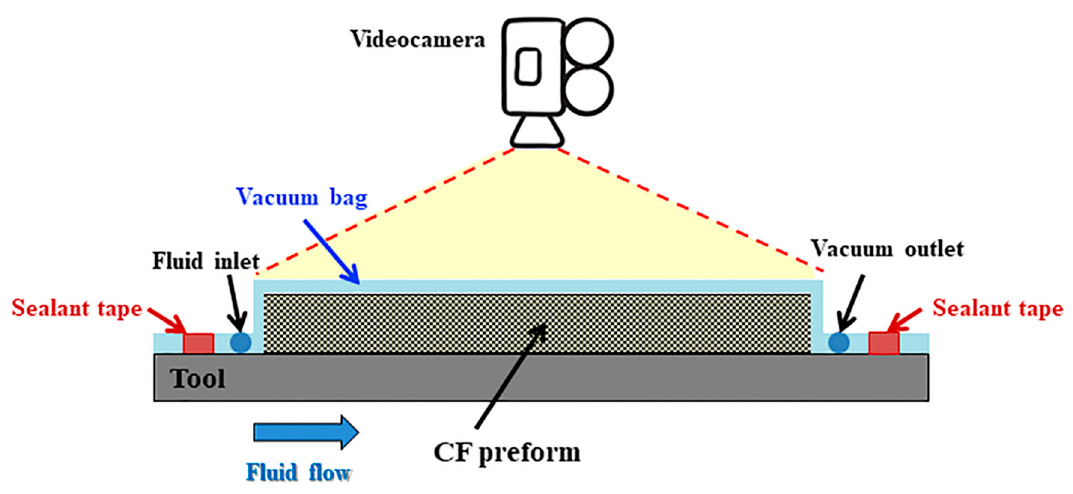
Figure 2. Sketch not in scale for the measurement of the in-plane permeability in a resin infusion process.